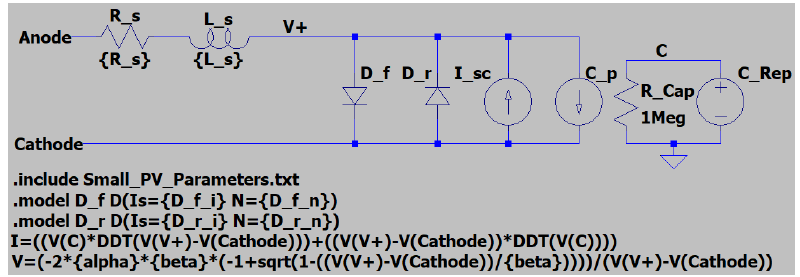
Figure 15. The FCPVM, implemented in LTspice. Developed from